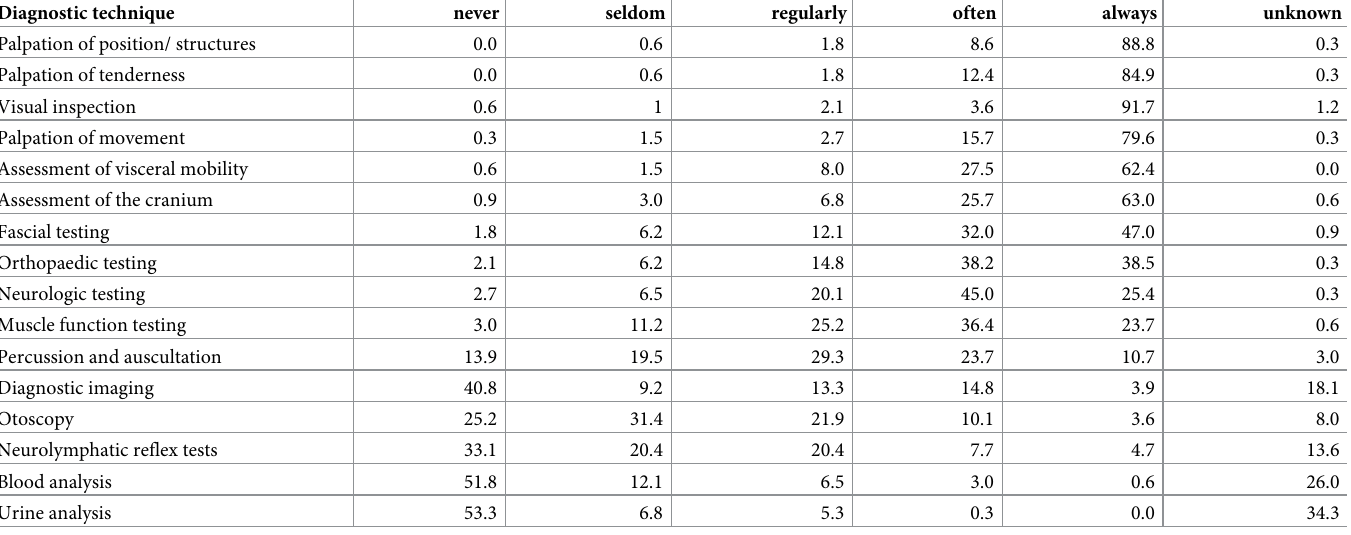
Table 5. The most common diagnostic techniques used (in descending order of ‘often’ and ‘always’ responses).